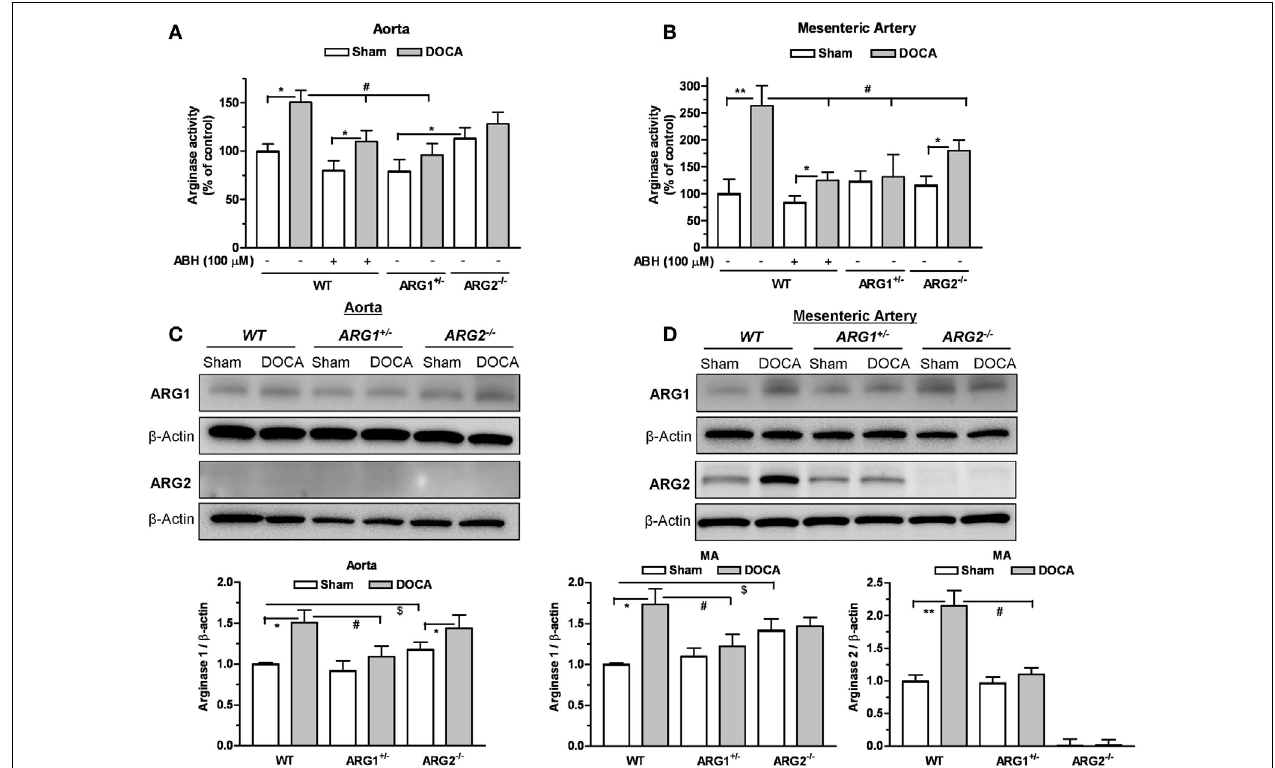
inhibitor of arginase (ABH, 100 µ M) prevented elevation of arginase activity in aorta and MA inWT-DOCA-salt treated mice (A,B) . Measurement of protein expression of ARG1 and ARG2 in aorta (C) and MA (D) of animals treated with Sham or DOCA-salt treatedWT, ARG1 + / − , or ARG2 − / − mice. Arginase activity inWT Sham group was considered as 100%. Data represents mean ± SEM of five to seven experiments. * P < 0.05, ** P < 0.01, compared with its respective Sham group. # P < 0.05, compared withWT-DOCA group. $ P < 0.05, compared withWT Sham